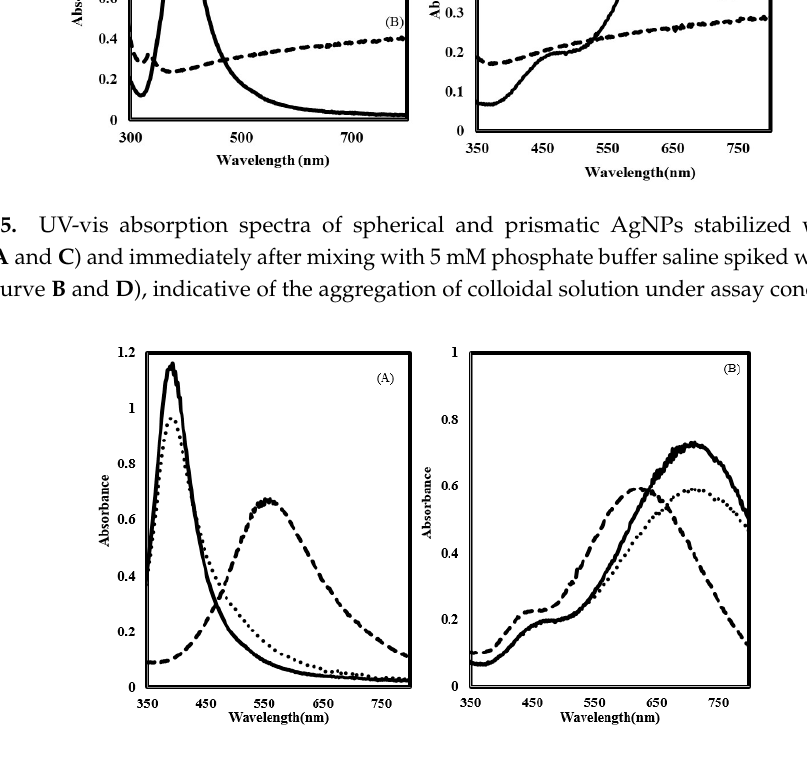
Figure 6. ( A ) Absorption spectra of spherical silver capped with citrate ( ─ ), polyvinylpyrrolidone (PVP) ( ∙∙∙ ) and poly-Arg-PVP ( - - ). ( B ) Absorption spectra of prismatic silver capped with citrate ( ─ ), PVP ( ∙∙∙ ) and poly-Arg-PVP ( - - ).